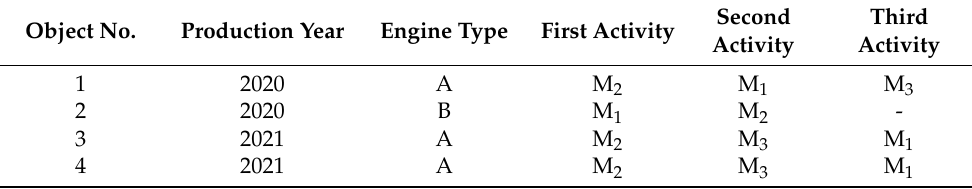
Table 1. Sample of collected data. Object